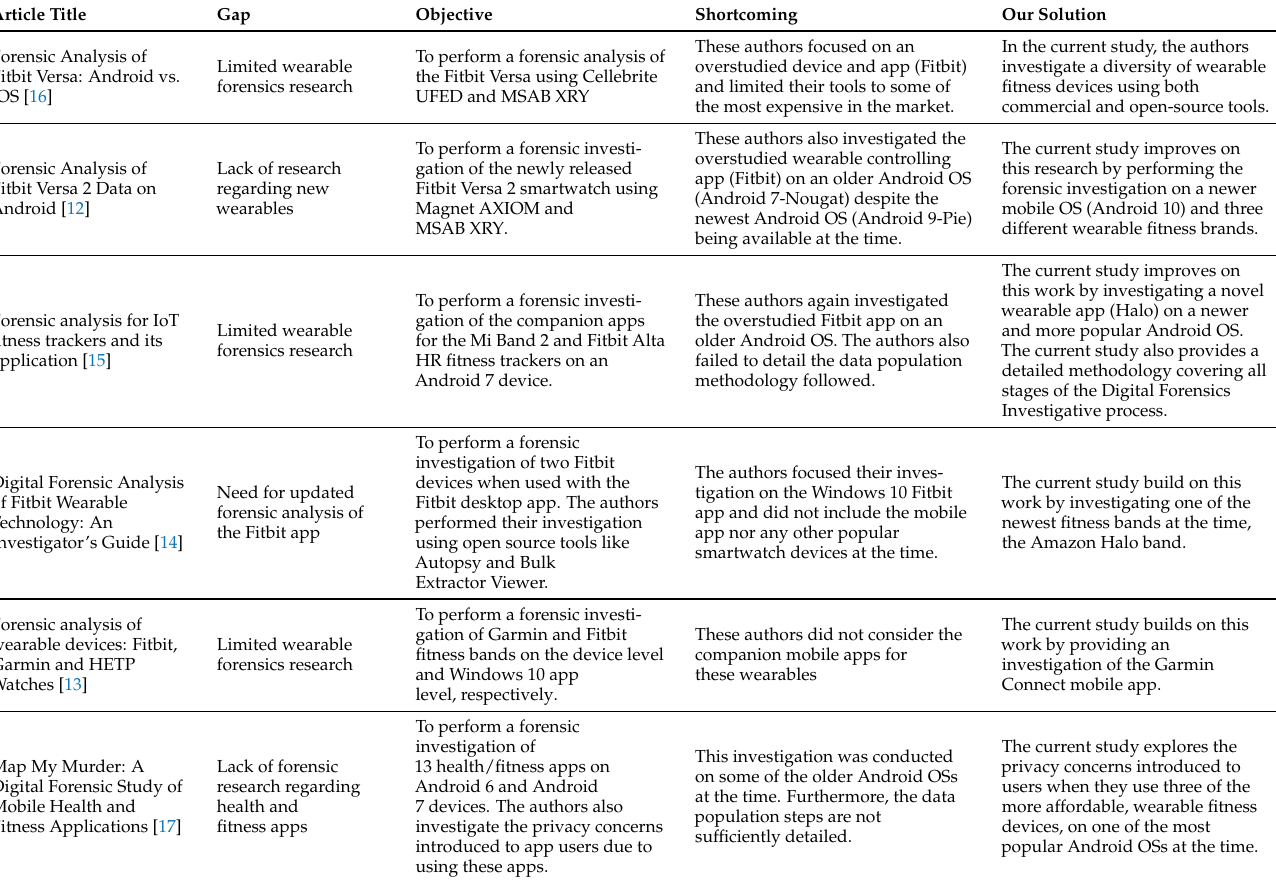
Table 1. Summary of Literature Review and Current Study